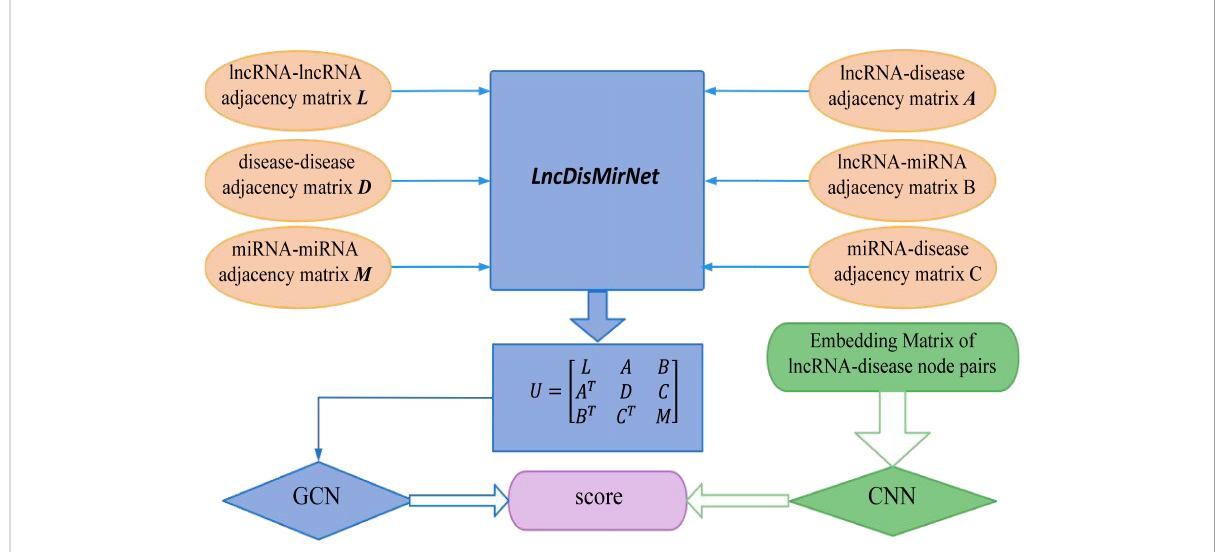
FIGURE 7 From the work fl ow, GCNLDA based on a graph convolutional network and a convolutional neural network was developed to learn network and local representations of the lncRNA-disease